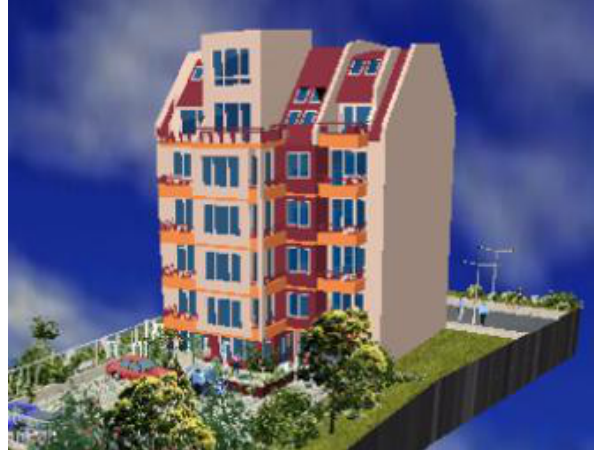
Figure 8. Photorealistic modelling based on architectural